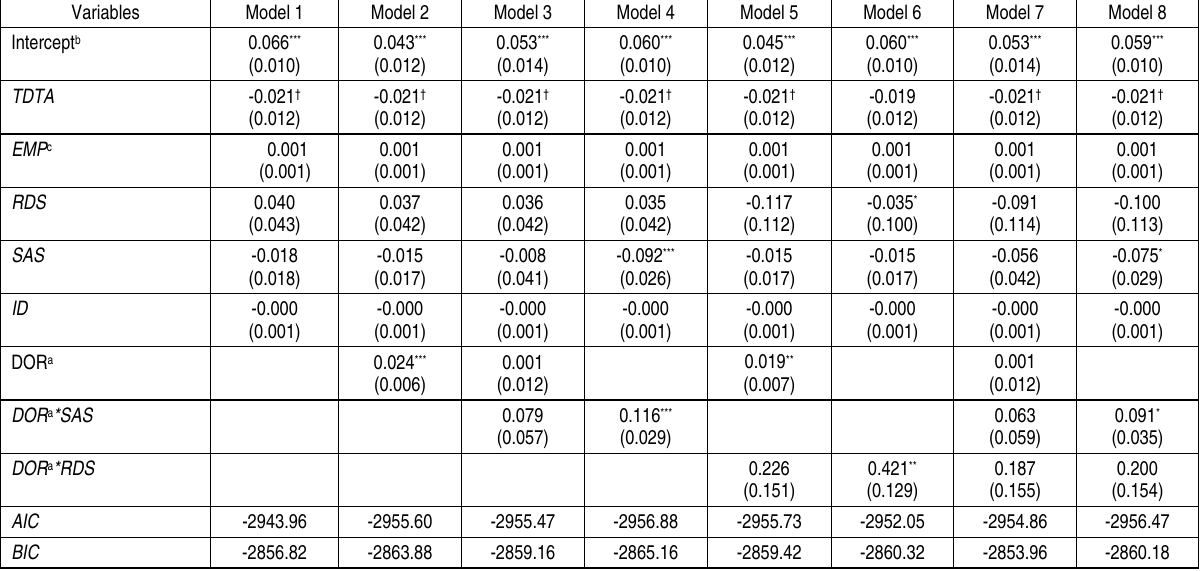
Table 4. Results of multilevel analysis a for testing Hypotheses 1 and 2a,